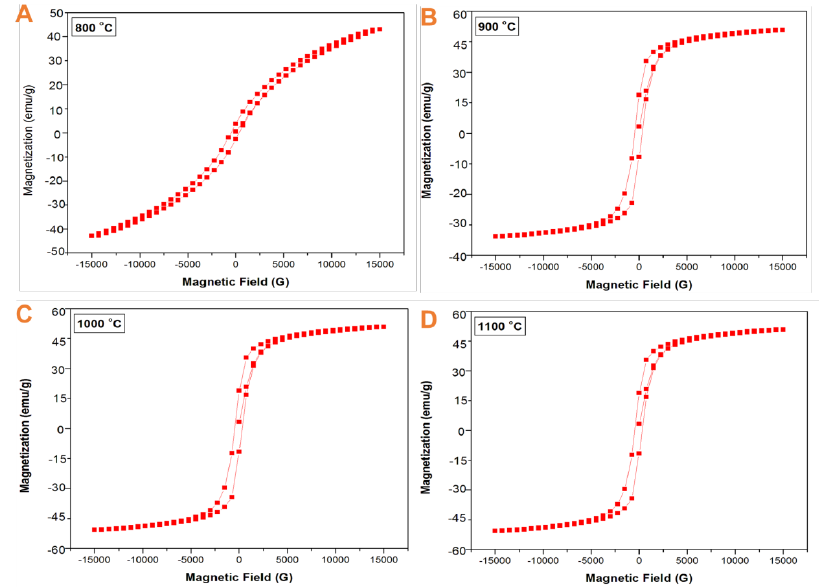
Figure 7. ( A – D ) . Magnetization curves of the GdFeO 3 nanoparticles at different temperatures. Table 3. Magnetization of gadolinium